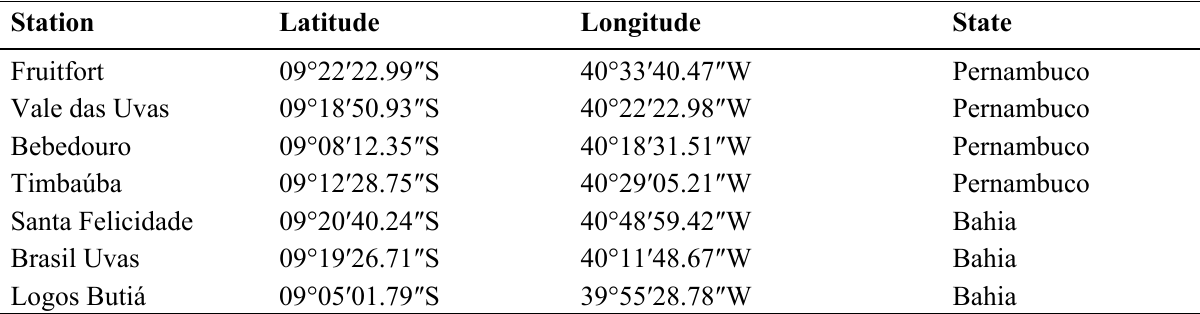
Table 4. Agro-meteorological stations used for the regional radiation balance and reference evapotranspiration